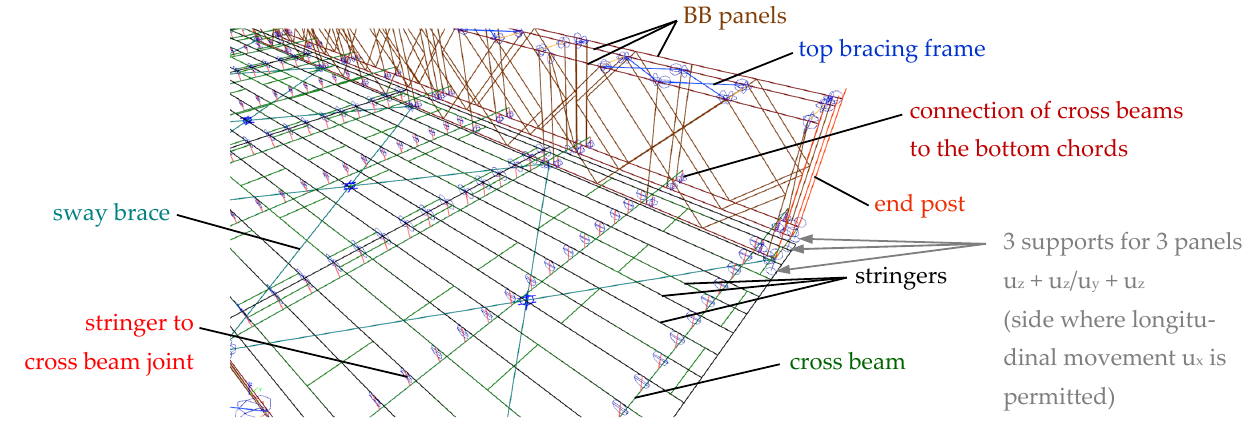
Figure 7. Some notes on spatial FEM models of steel superstructure of Bailey bridge.